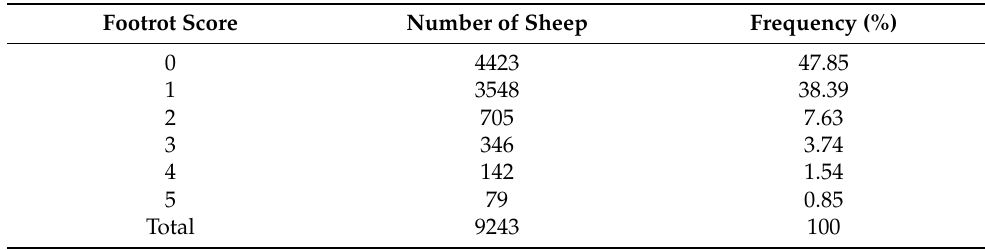
Table 4. Numbers and percentages of footrot scores determined in 9243 German sheep from 207 flocks.